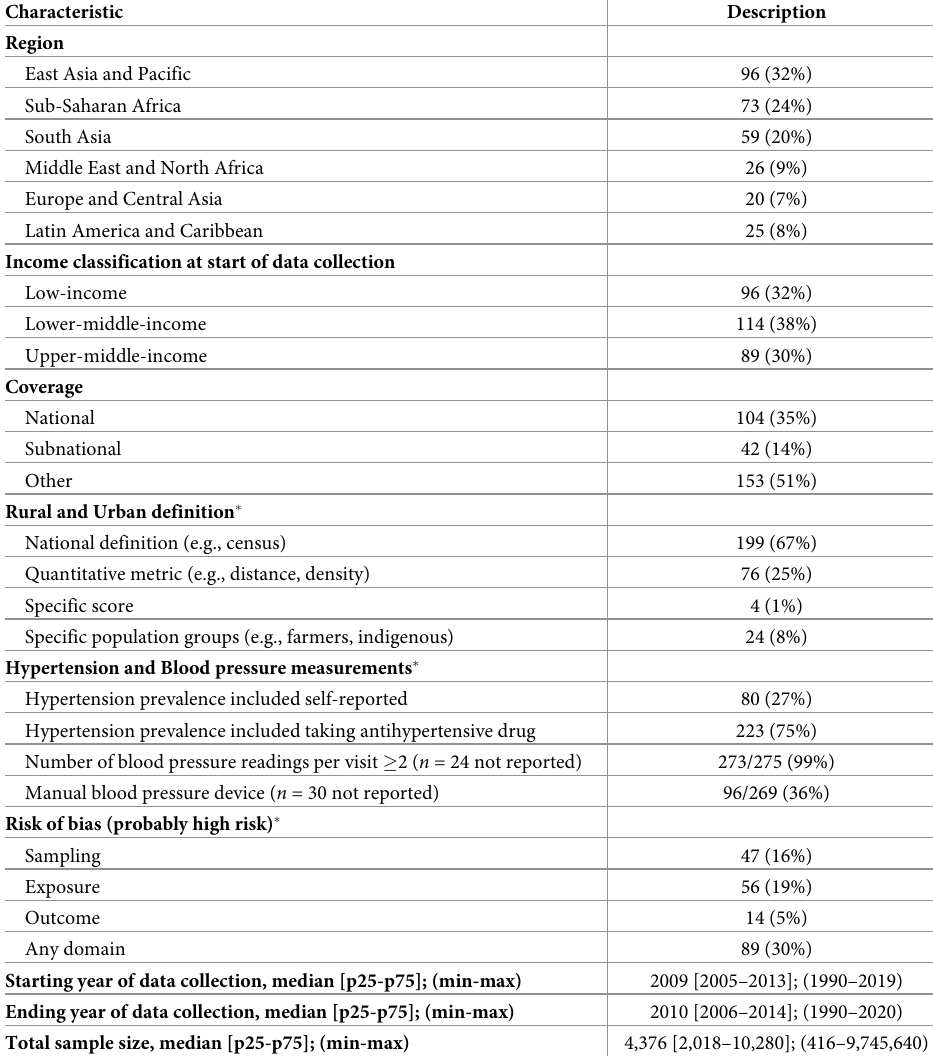
Table 1. Overall characteristics of the 299 surveys included from 66 LMICs.